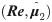
Parametric diagram of blood coagulation system regimes in the (Re,μ~2) parameter space.
Re is the Reynolds number and μ~2 is the non-dimensional vessel wall permeability. Label “I” is used to denote stationary regimes with no coagulation in the vessel while “II” marks the regimes with thrombi formation. Also shown are two typical values Re
1, Re
2 marking the boundary of the coagulation regime for a given μ~2 and μ~min—the permeability of the vessel wall below which clotting does not occur under any hydrodynamic conditions. Finally, Re = Re
τ2 indicates the lowest Reynolds number at which the shear stress reaches τ
2 and the local permeability of the vessel reaches μ2~. h = 0.6, d = 0.4.